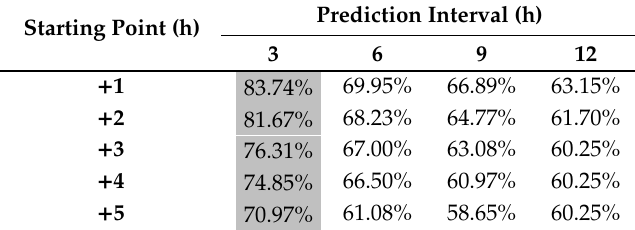
Note: highlighted in gray are the percentages larger than